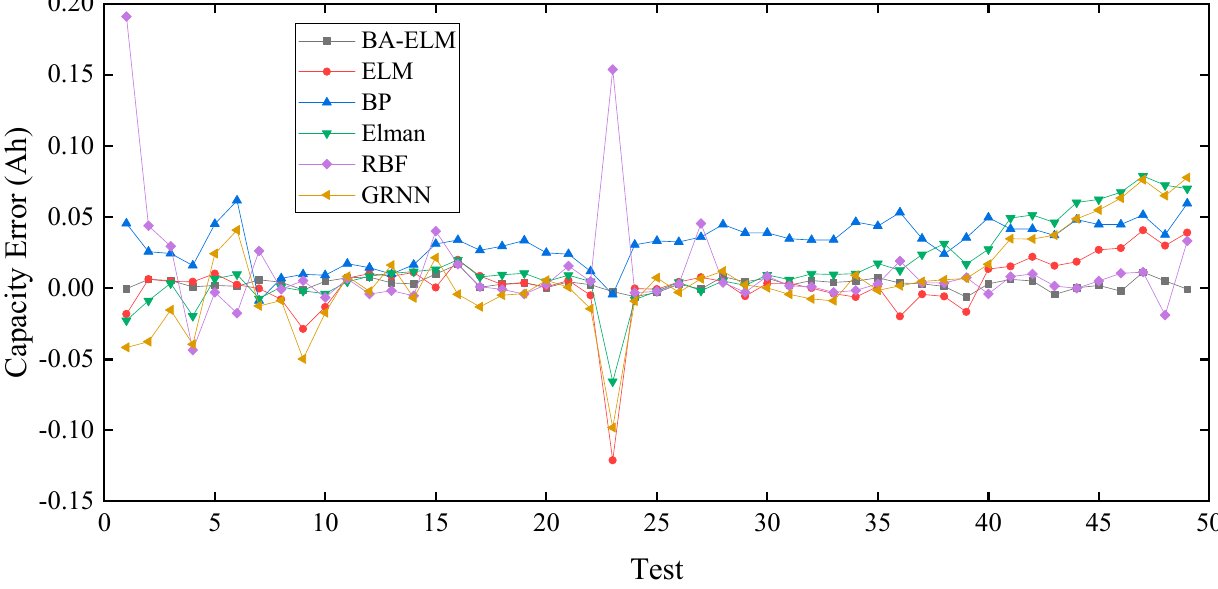
Figure 17. Comparison of estimation errors of C aged of each model.